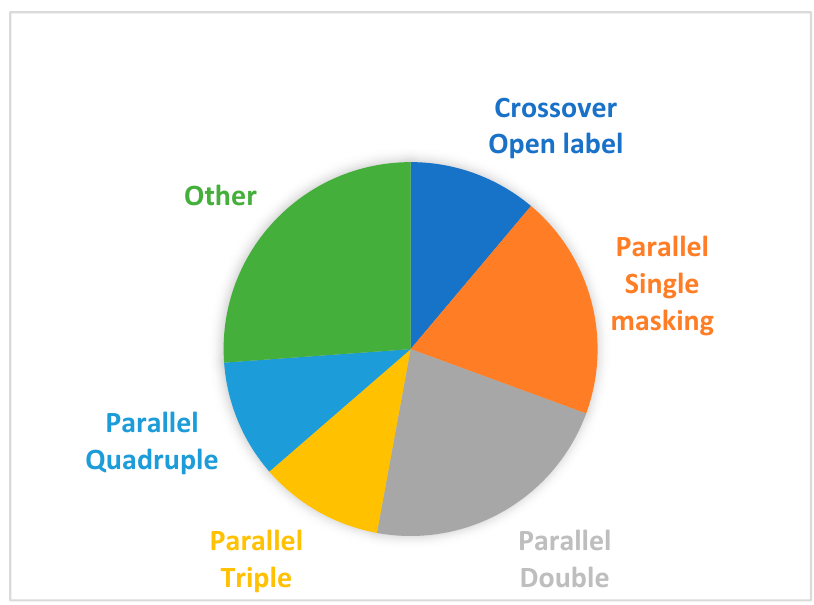
Figure 5. Study design.